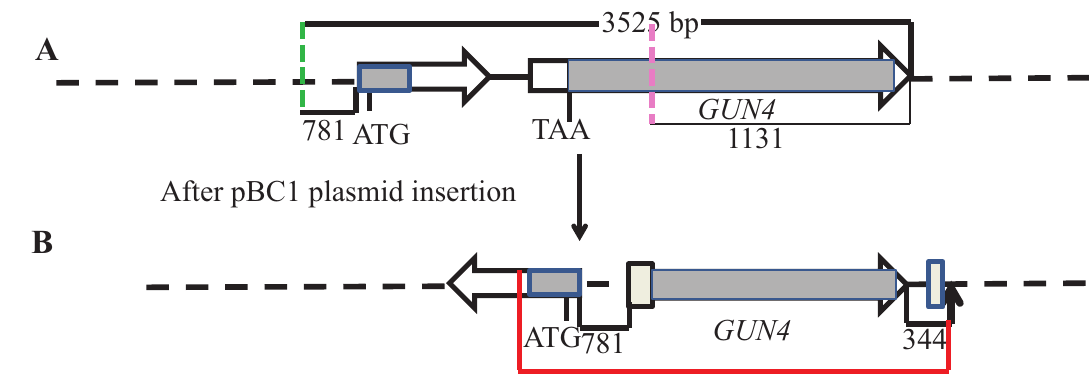
Figure S3. A schematic of the genetic rearrangement in 6F14 based on TAIL PCR analyses. ( A ) A schematic genomic map showing a 3525 bp genomic DNA region spanning the GUN4 locus. The number at the bottom of the map denotes distance between respective points on the genomic DNA. The two GUN4 exons are represented by white block arrows. Grey boxes in GUN4 denote UnTranslated Regions (UTRs). The two break points are shown by the dashed pink and green lines. ( B ) A schematic diagram showing the rearrangement of the GUN4 locus after the insertion of the plasmid. The big and the small tan boxes, denote addition of 45 and 29 bp, respectively. The genomic DNA sequence obtained by sequencing the 2.9 kb Thermal Asymmetric InterLaced2 (TAIL2) PCR product is highlighted in red. The bold black small arrow indicates insertion point of the pBC1 plasmid. DNA sequencing was performed using GUN4 specific primers 2R, 7F and 7R, 12R and 14R. F and R stand for forward and reverse primers, respectively. Primer sequences are shown in Table 2.